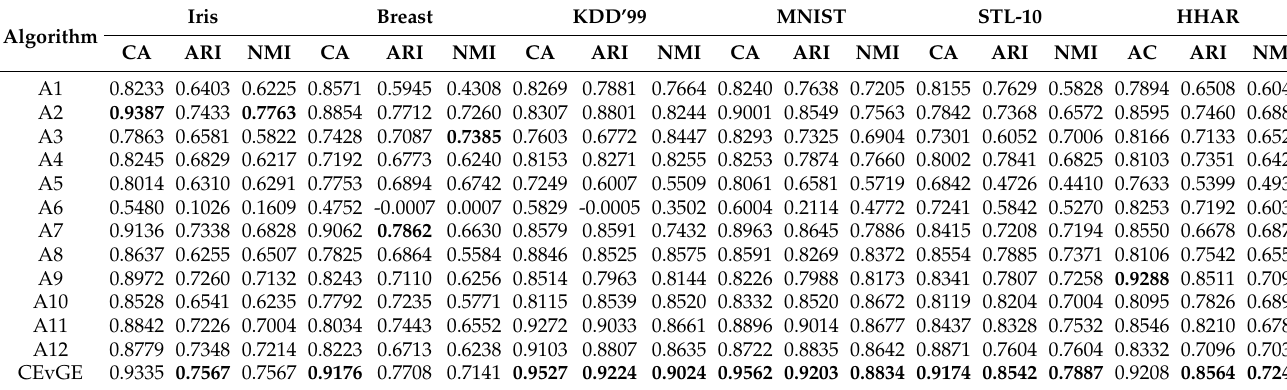
Table 5. External indexes of different algorithms on real data sets.